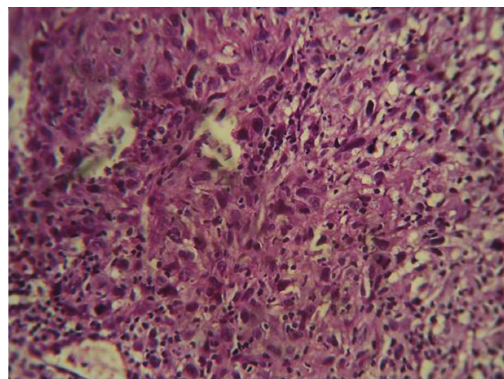
Figure 6: Neoplastic cells displaying intense immunoreactivity for vimentin